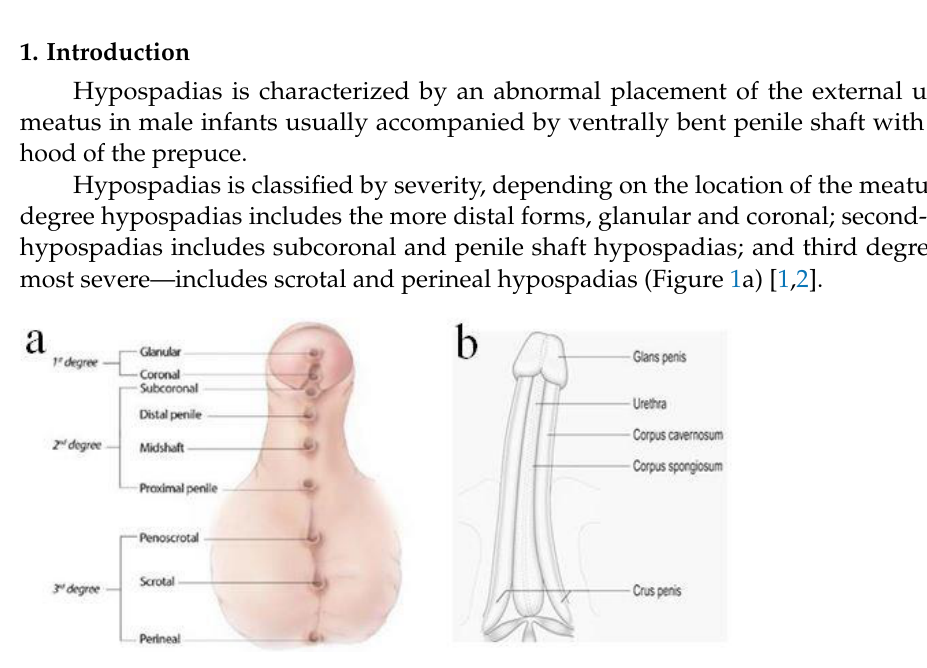
Figure 1. Classification of hypospadias according to the opening of meatus ( a ). Normal penile shaft ( b ).